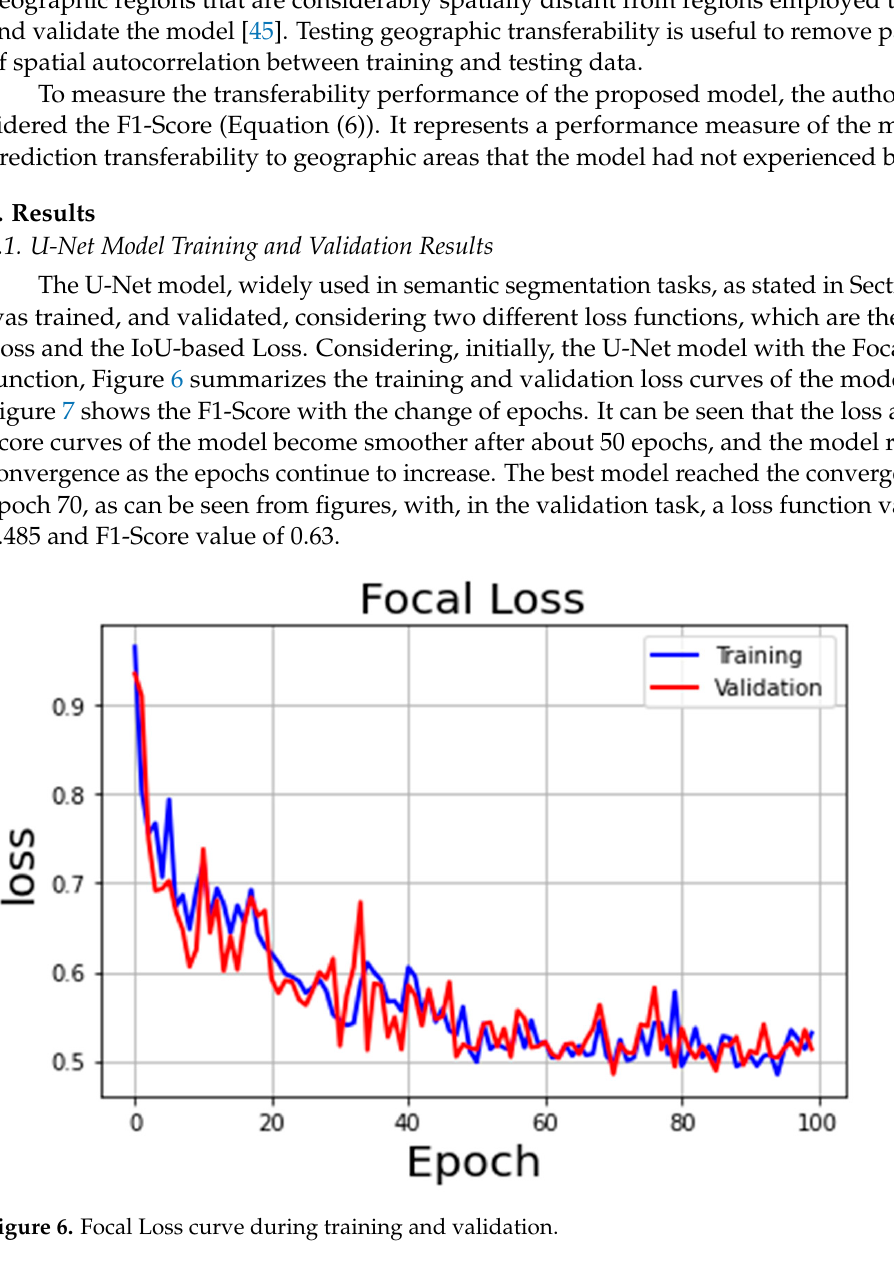
Figure 7. F1-Score during training and validation using Focal Loss. Figure 8 summarizes the training and validation loss curves of the U-Net model with IoU-based loss, and Figure 9 shows the F1-Score with the change of epochs. The best model reached the convergence at epoch 91 with, in the validation task, a loss function value of 0.634 and F1-Score value of 0.72.